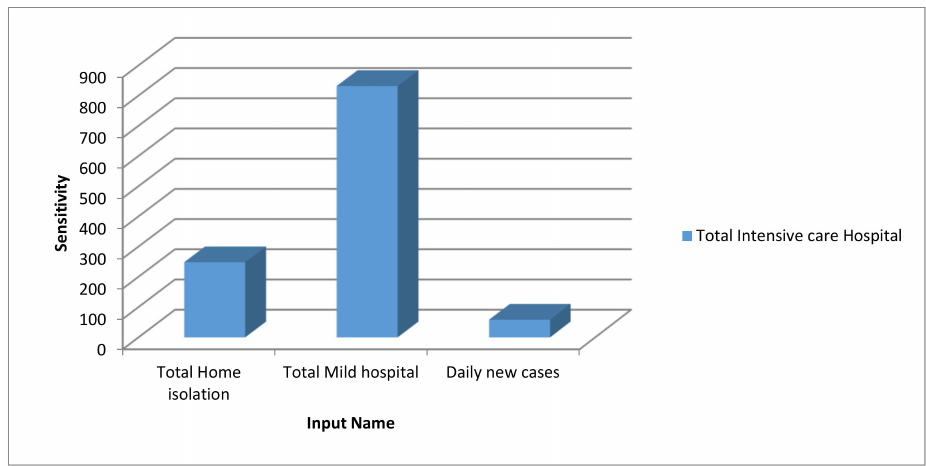
Figure A2. The impact of each variable on the result (Intensive case in the hospital) for testing data set.